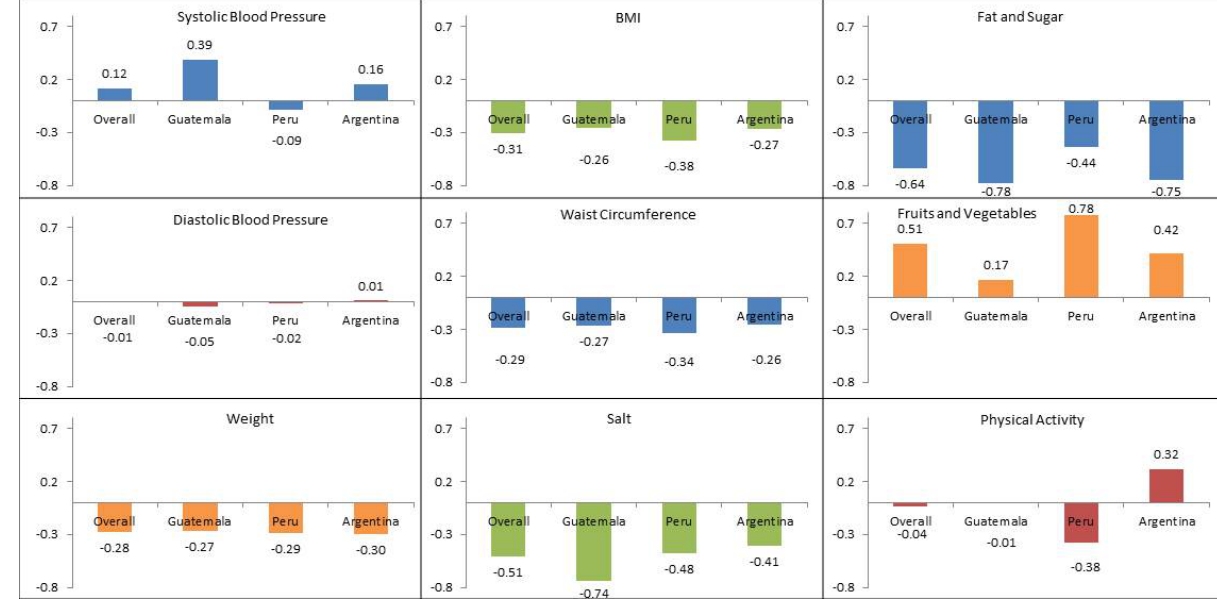
Figure 1. Assessed outcomes of subjects who received ≥ 75% of the intervention overall and by country. BMI: body mass